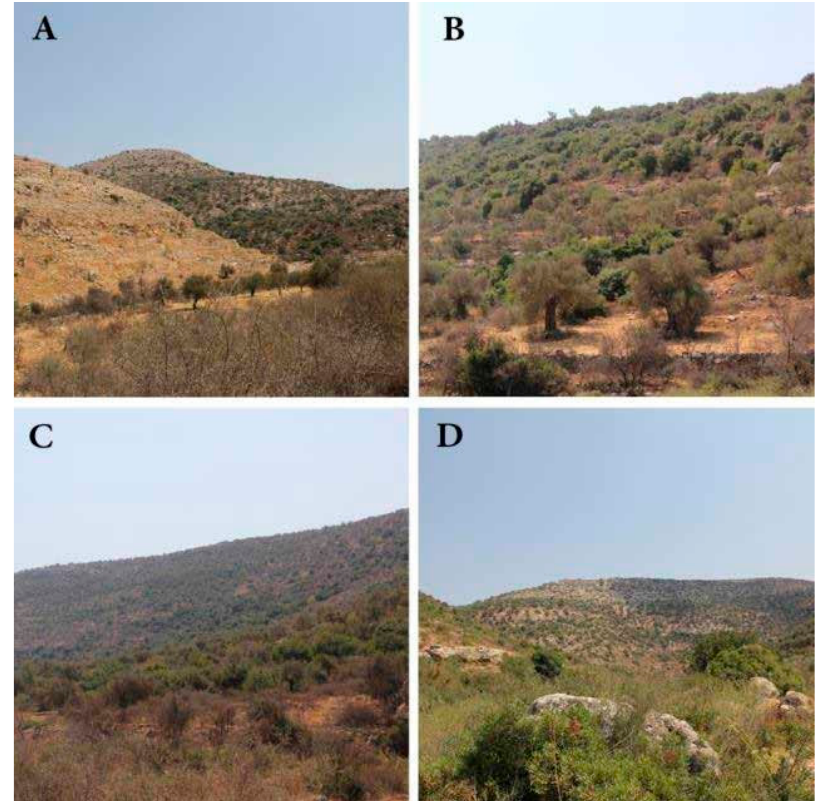
Figure 3. Habitats in WZ: ( A ): Olives in the valley with different coverages of vegetation on two sides of the valley; ( B , C ): Typical Mediterranean habitats of oaks, carobs, and hawthorn on the less accessible hills, but human cultivation of trees in the valley; ( D ): Less dense Garigue vegetation in the western part of valley and hillside (mostly